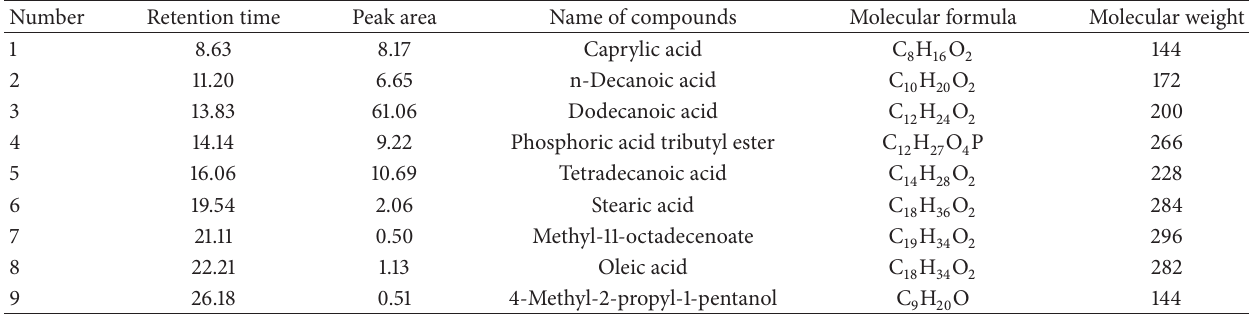
Table 2: Bioactive compounds in ethanolic extract of Lenzites quercina .